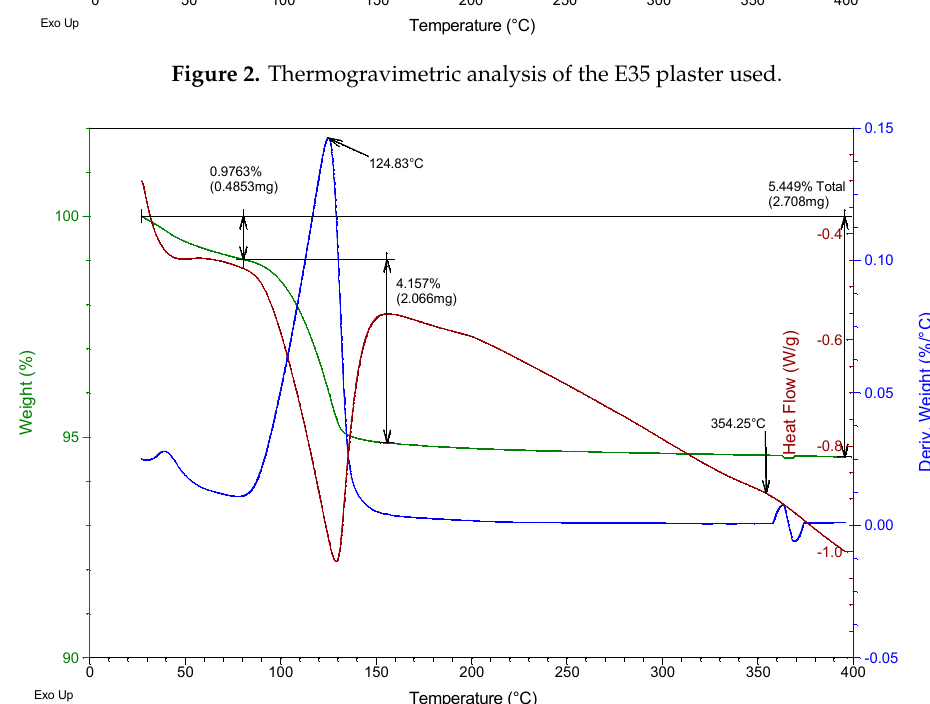
Figure 3. Thermogravimetric analysis of the fine gypsum YF used.